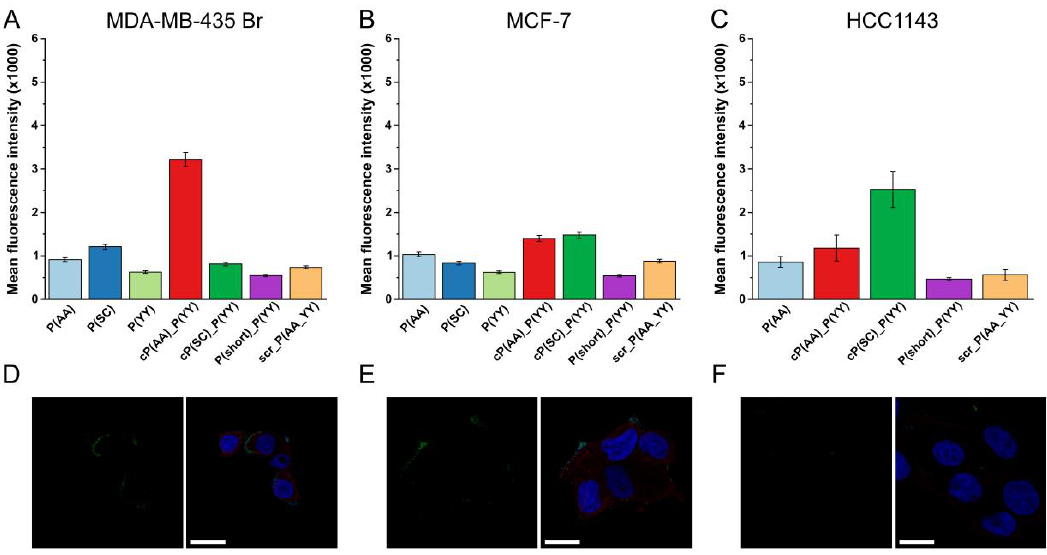
Figure 5. Cellular uptake of HER2-specific compounds by cell lines with a lower HER2 expression. ( A,B,C ) Flow cytometry analysis of the HER2 binding compounds (12.5 µM) on cell lines with a medium or lower HER2 expression after 3 h incubation. Flow cytometry was measured by a BD LSR II flow cytometer. The mean and standard deviation of two parallels are depicted. The experiments were repeated twice. ( D,E,F ) Confocal microscopic imaging of cP(AA)_P(YY) (25 µM) after 90 min incubation is shown in green. HER2 was detected with the anti-HER2 antibody and the TRITC-conjugated secondary antibody (as shown in red). Nuclei were stained with DAPI (blue). The Zeiss LSM 710 system was used for image acquisition. Scale bars represent 20 µm.